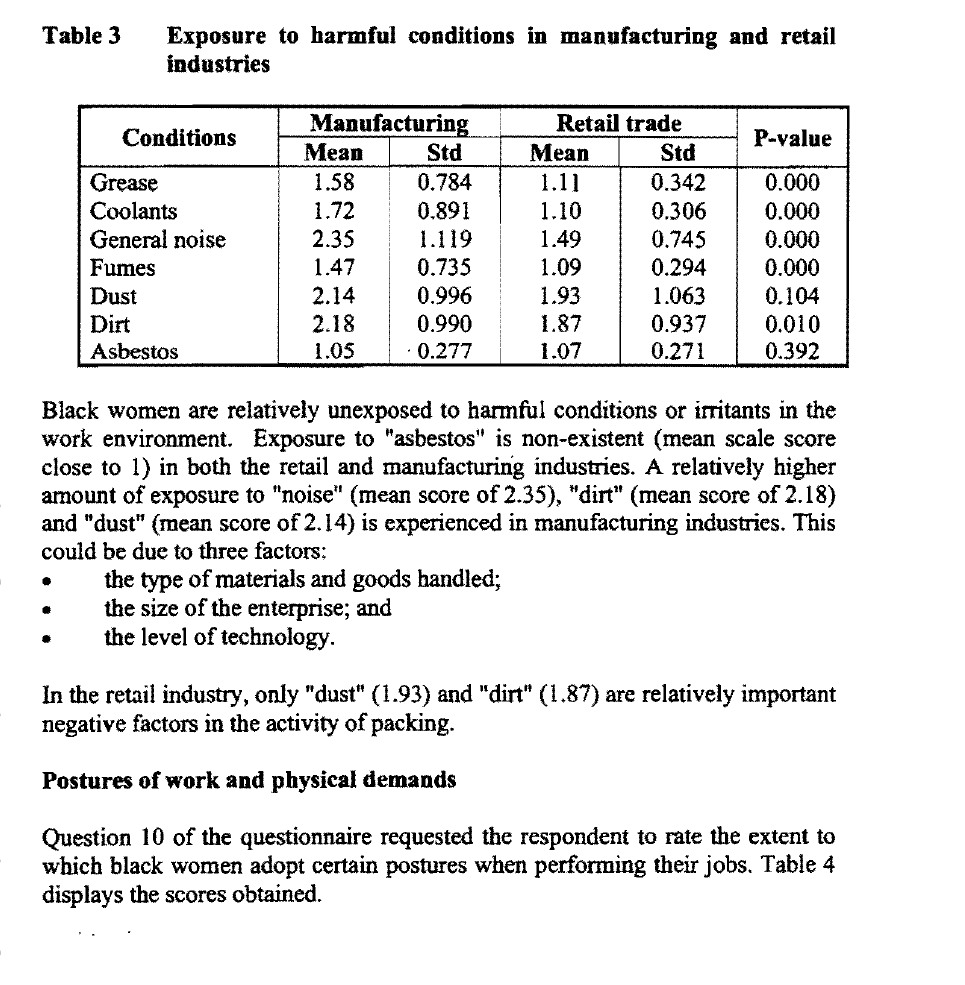
Exposure to harmful conditions in manufacturing and